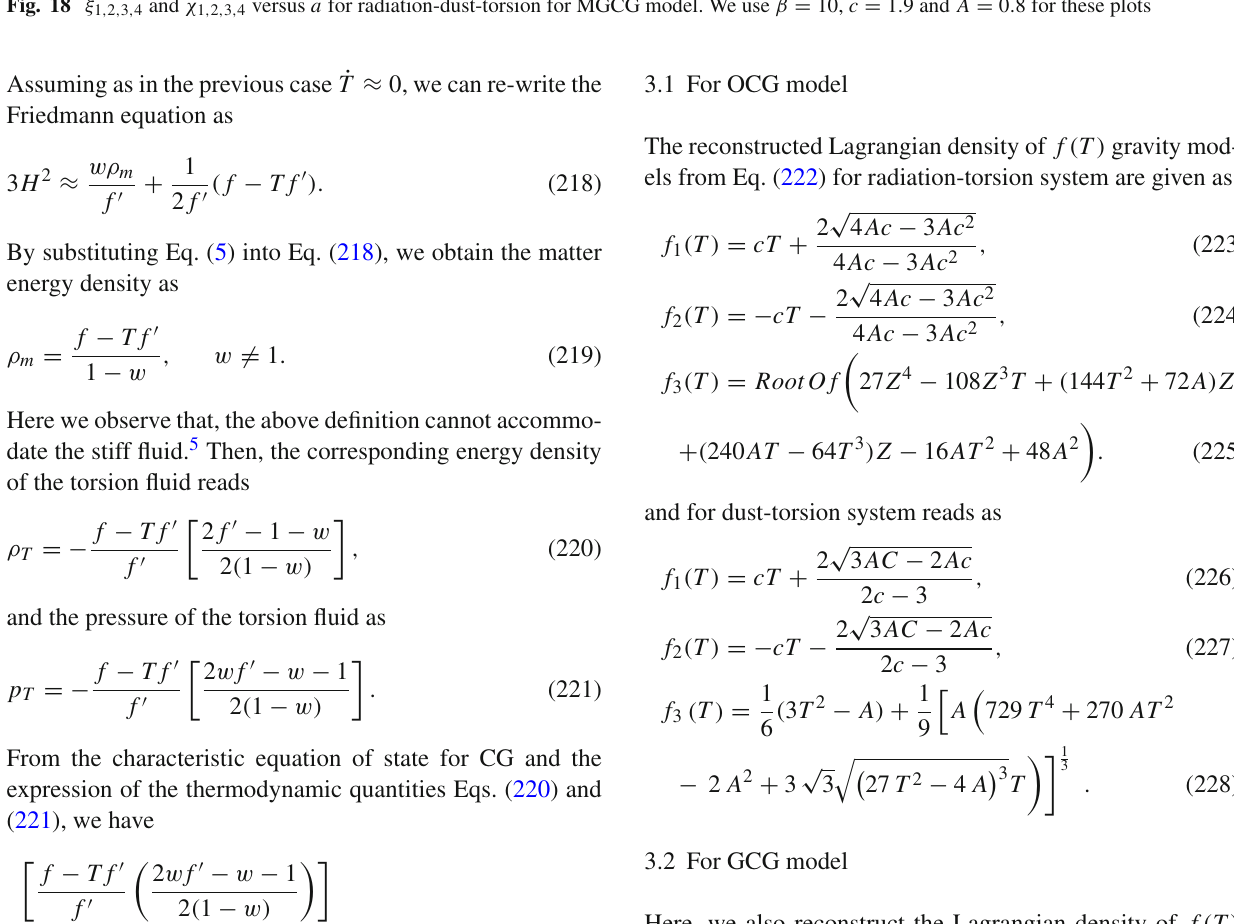
Fig. 18 ξ 1 , 2 , 3 , 4 and χ 1 , 2 , 3 , 4 versus a for radiation-dust-torsion for MGCG model. We use β = 10, c = 1 . 9 and A = 0 . 8 for these